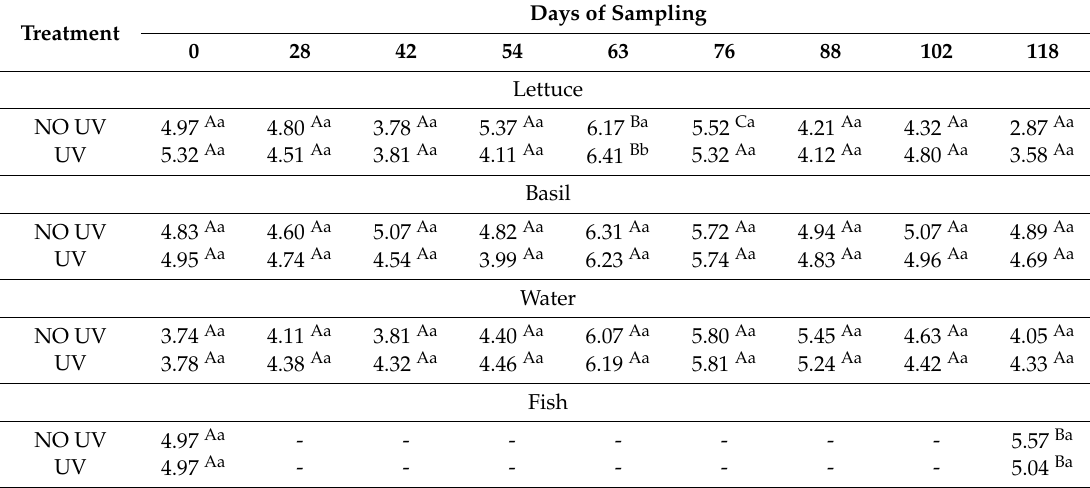
Table 1. Log 10 of aerobic plate counts collected from basil, water, lettuce, and fish over 118 days in an aquaponic model